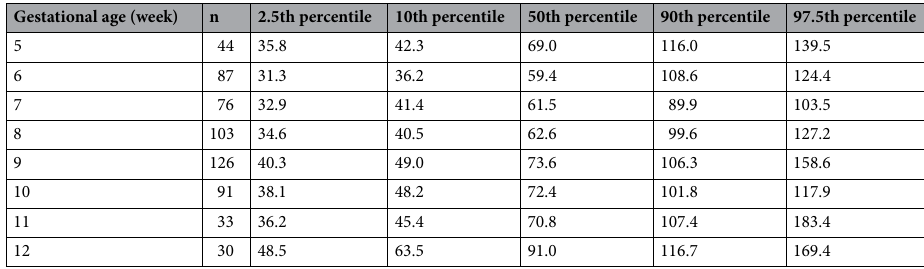
Table 2. Gestational age-specific 2.5th, 10th, 50th, 90th and 97.5th percentile normative values of serum progesterone (nmol/L) in 590 women.